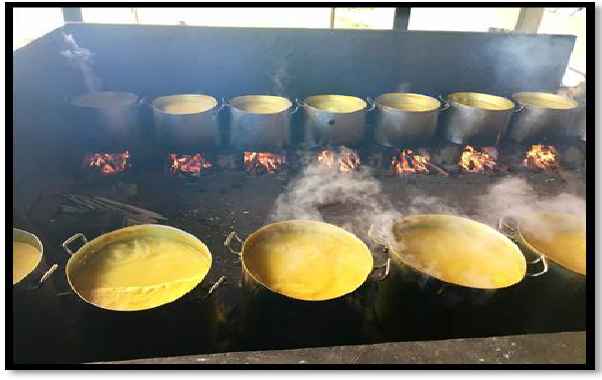
Figura 6: Preparo do tucupi.